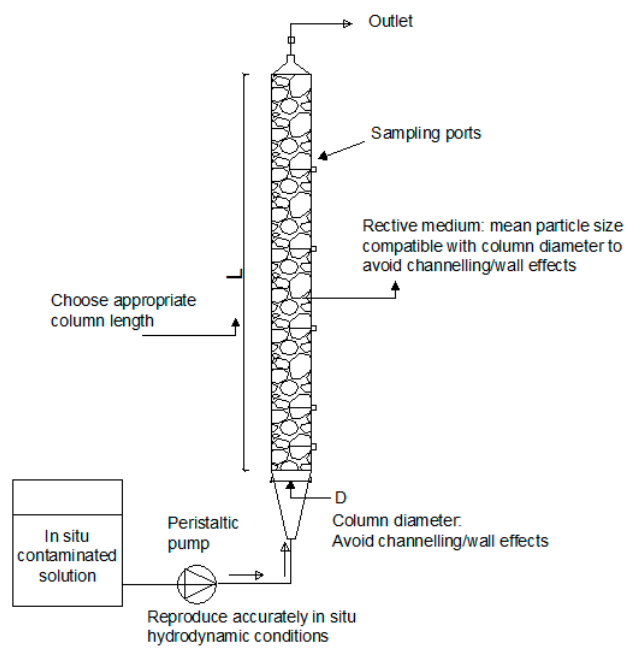
Figure 4. An example of a column test apparatus.